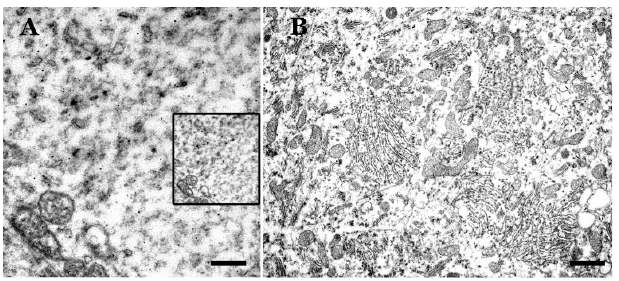
Figure 3. Electron microscopy images of the basal region of non ‐ normal Purkinje neurons. Scrapie sheep in clinical phase. ( A ) Dystrophic cell with cytoplasmic rarefaction (dissolution/loss of sub ‐ cellular organelles). Not defined debris are observed. Tubulo ‐ vesicular formations appear (more notable in the upper left part of the image) as well as other electrodense microvesicles. Insert: mag ‐ nification similar to ( B ) for comparison. ( B ) Hypertrophic cell (diameter, 42 μ m) with a great abun ‐ dance of subcellular organelles, although rough endoplasmic reticulum (RER) is more disor ‐ ganized. Selected cytoplasmic regions are similar of those control neurons, but others resemble what is seen in dystrophic neurons (Bar: A = 0.5 μ m; B = 3 μ m).